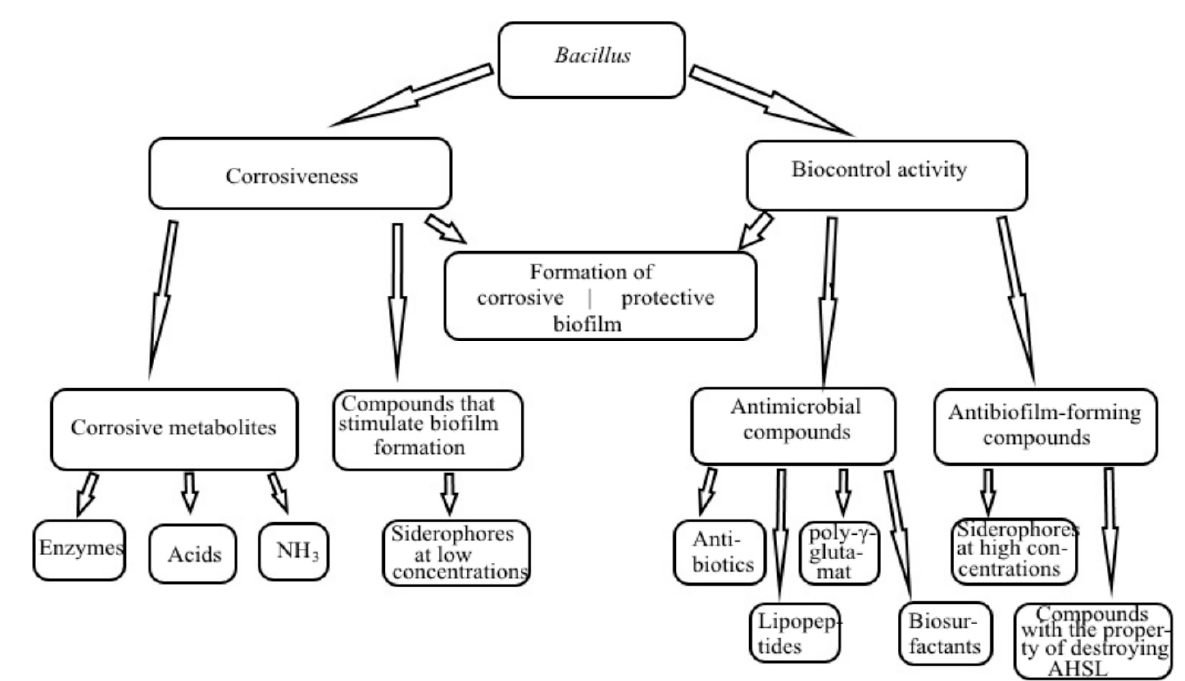
Figure 5. Mechanisms of participation of bacteria of the genus Bacillus in biodamage of some metals and plastics.